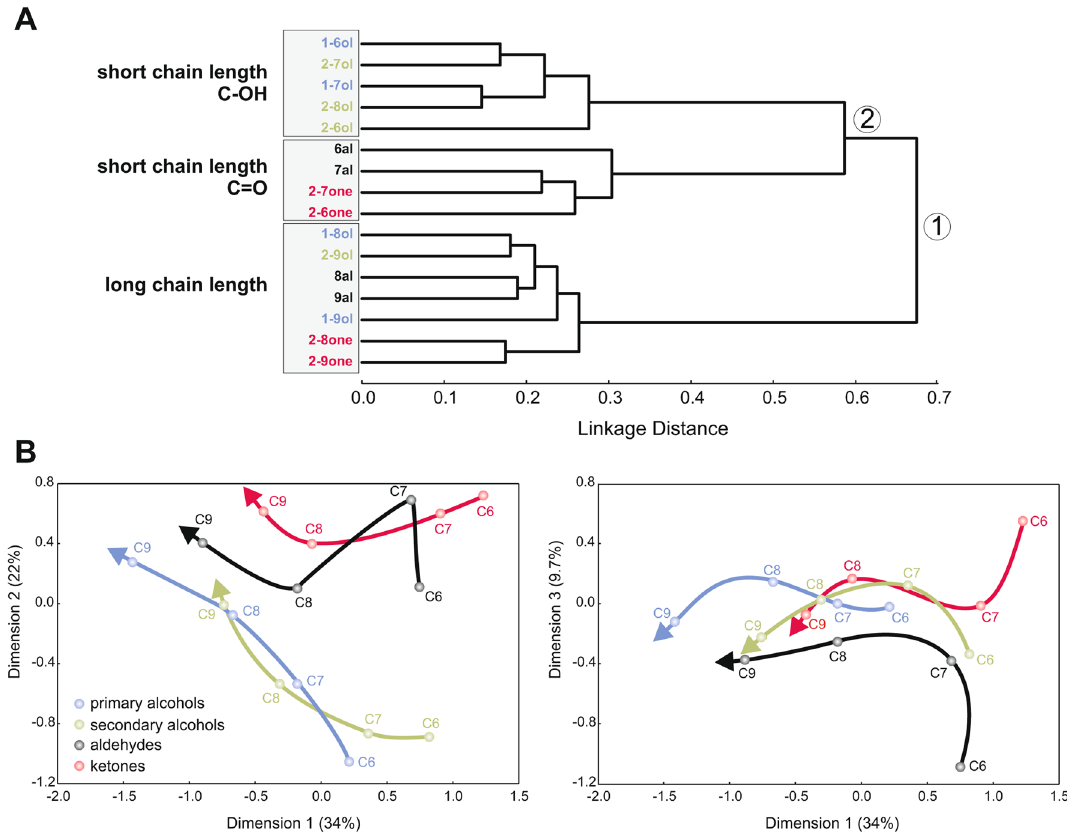
Figure 5. Multidimensional analyses. ( A ) Cluster analysis showing similarity relationships among odorant response maps (Ward’s classification method). Short linkage distance between branches indicates odorants with similar response maps. Functional groups are shown in different colors: primary alcohols in blue, secondary alcohols in green, aldehydes in black, and ketones in red. The analysis shows a first separation (node 1) between odorants with short and long carbon chain lengths. Odorants with a short carbon chain are then subdivided (node 2) into alcohols (primary and secondary, C–OH functional group) and ketones/aldehydes (C = O functional group). ( B ) Multidimensional scaling analysis based on the Euclidian distance matrix for the 16 odorants. The first dimension (left panel) explains 34% of overall variance and orders molecules according to their chain length from short (on the right, C6 and C7) to long (on the left, C8 and C9). The second dimension explains 22.5% of variance and distinctly separates alcohols (blue, green) from ketones (red) and aldehydes (black). Functional group separation is clearer for short-chain than for long-chain molecules. The third dimension (right panel) explains 9.7% of variance and separates aldehydes (black) from other molecules. Altogether, odorants’ chain length and functional group represent main coding dimensions for odorants in l-ALT projection